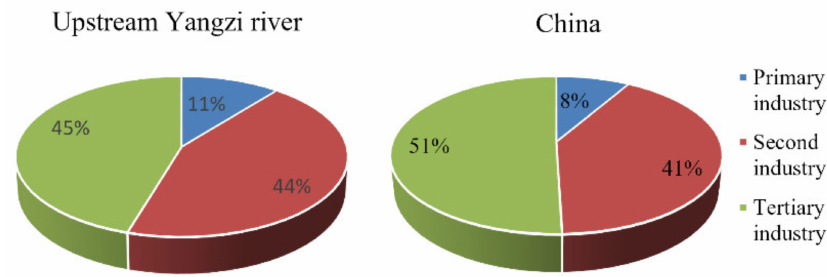
Figure 3. Industry structure in upstream Yangtze River Basin and in